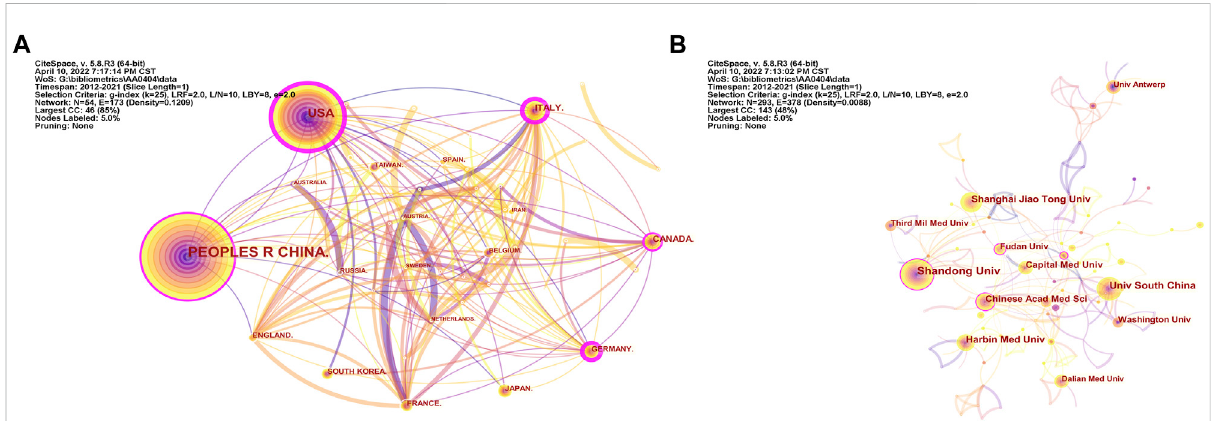
FIGURE 2 Countries and Institutions Analysis. (A) Analysis of national cooperation based on CiteSpace visual map; (B) Analysis of institutional cooperation based on CiteSpace visual map. Each node represents a country or institution, and its size re fl ects the number of contributions. The connections between nodes re fl ect the relationships between